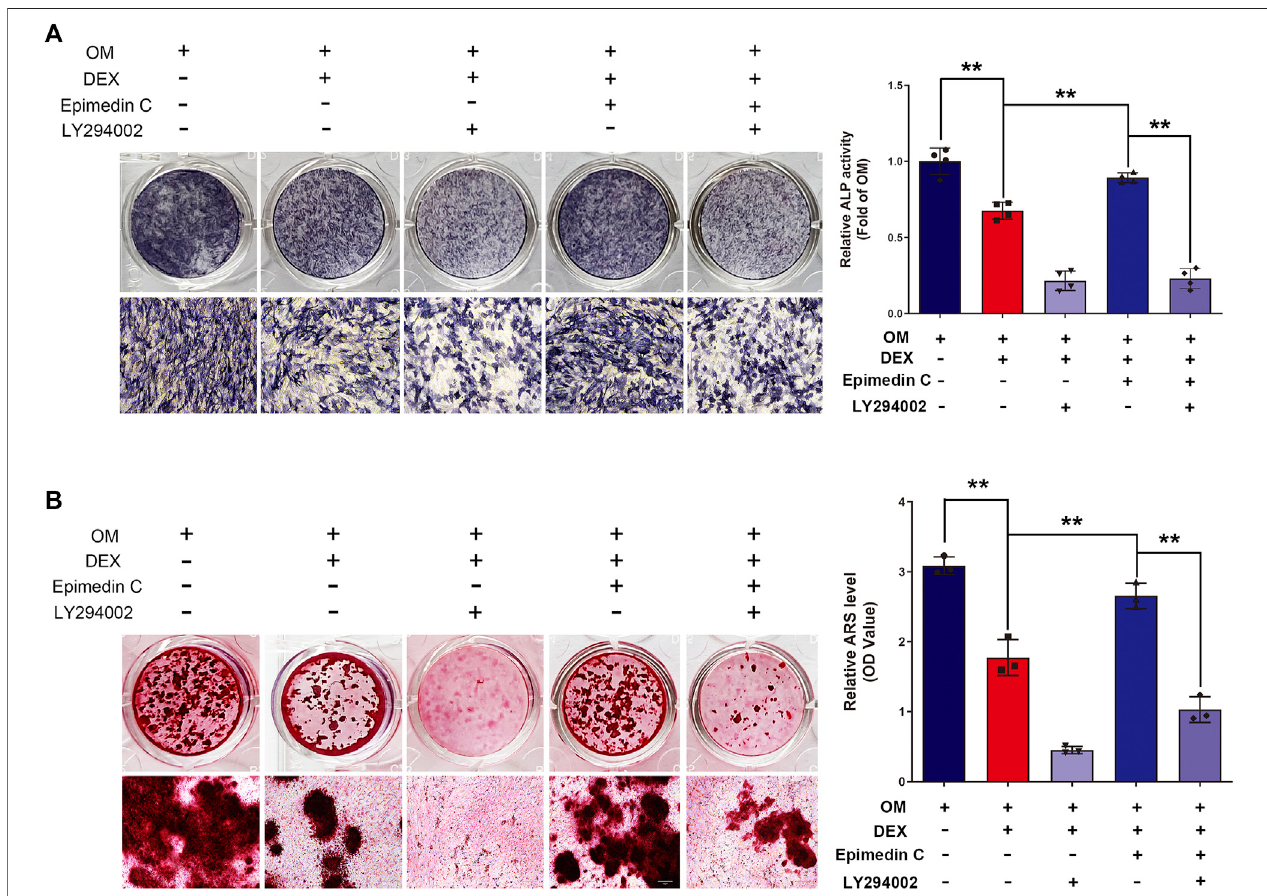
FIGURE 6 | In MC3T3-E1 cells treated with DEX, LY294002 decreased epimedin C ’ s protective activity. (A) After 5 days of treatment with LY294002, DEX, and epimedinC,theMC3T3-E1 cellswere stainedwithALP withthe aidoftheBCIP/NBT kit. (B) Following32 days oftreatmentusing LY294002, DEX,and epimedin C,the mineralized nodules were subjected to staining with alizarin red S. DEX, dexamethasone; OM, osteogenic induction medium. ** p < 0.01.